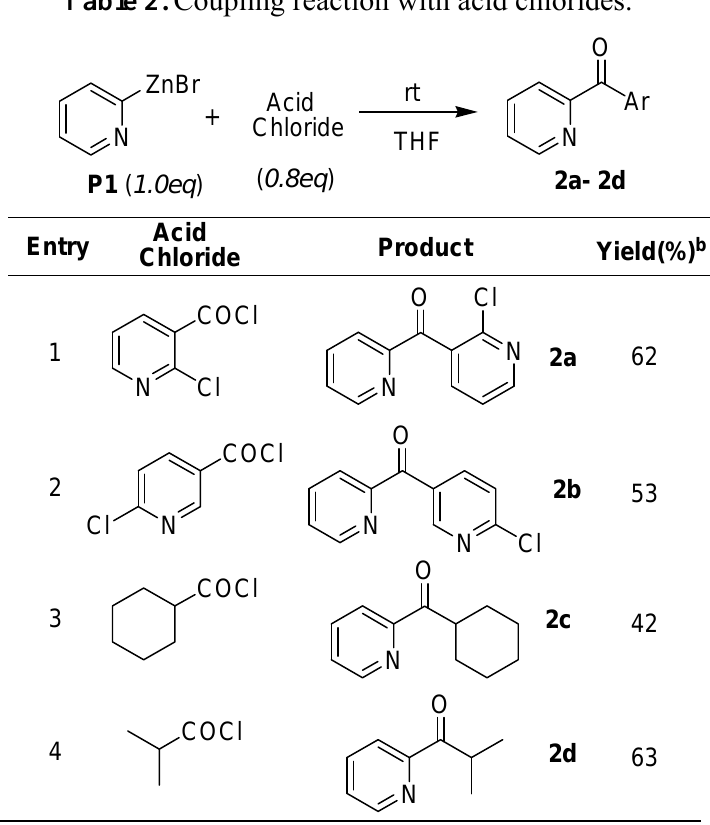
Table 2. Coupling reaction with acid chlorides. a